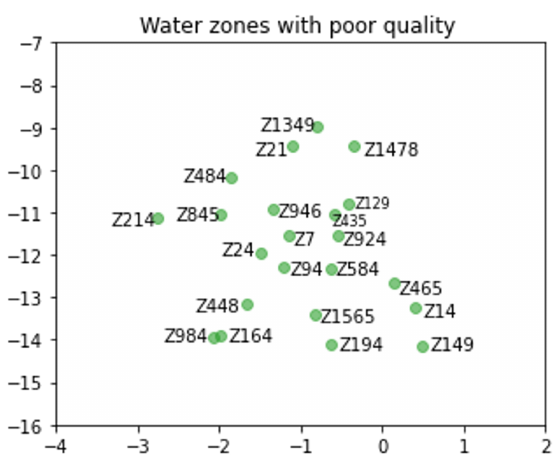
Figure 8. Water zones with poor quality.